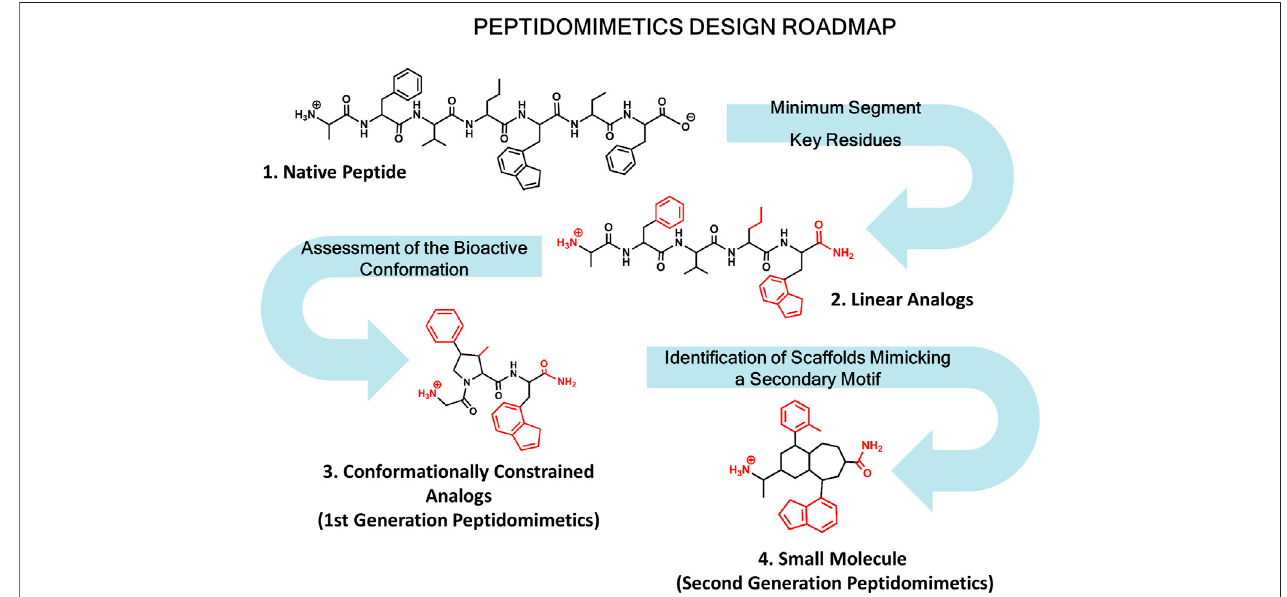
FIGURE1| Roadmapforpeptidomimeticsdesign.Startingfromthenativepeptide(1), fi rststepregardsestablishingtheshortestpeptidefragmentwithactivity,as well as identi fi cation of key residues involved in recognition (in red) (2). Next, using information about the secondary structure of the peptide in its bound conformation, proceedtodesignconformationallyconstrainedanalogsmimickingthebioactiveconformation(3).Theseanalogsrepresentthe fi rstgenerationpeptidomimetics.Finally, identi fi cation of small molecule scaffolds that permit a correct spatial arrangement of relevant chemical groups (identi fi ed in step 2) to yield second generation peptidomimetics